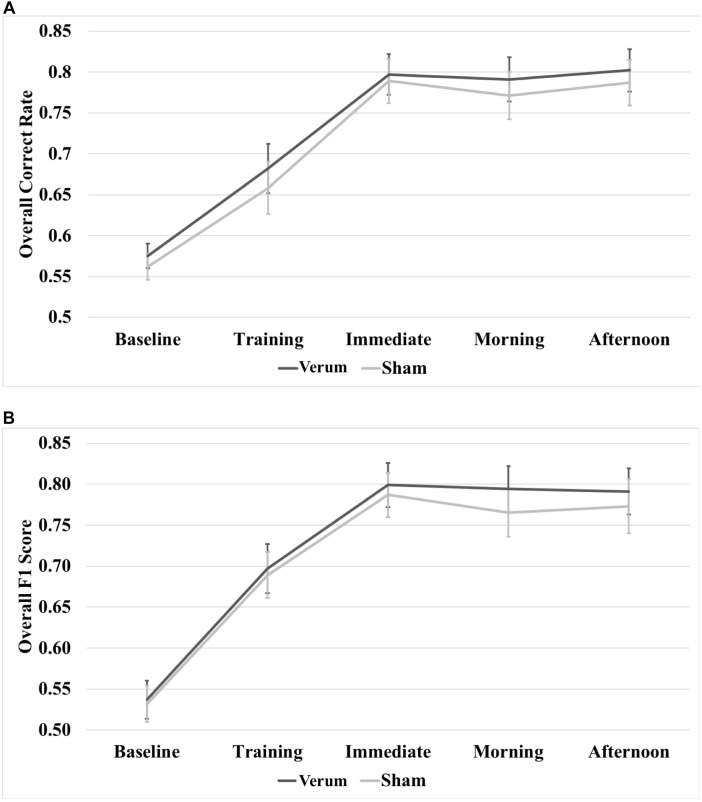
Raw performance scores through the experiment. (A) Overall correct rate through the experiment. (B) Overall F1 score through the experiment. There were no significant differences at any time point between verum and sham stimulation conditions. Error bars represent ±1 SEM.